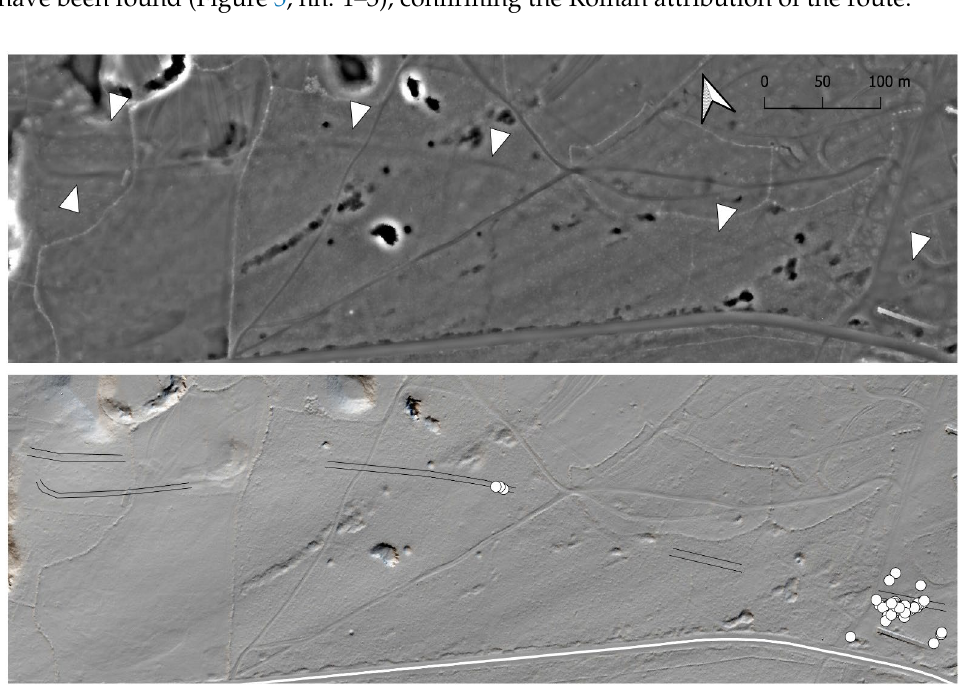
Figure 4. Zoomed view of area A of Figure 2 with the position of road tracks indicated by white arrows in the upper picture (local relief model of an ALS-derived DTM) and by black lines in the lower one (hill-shaded image of an ALS-derived DTM). White circles: caliga hobnails; white lines: modern roads.